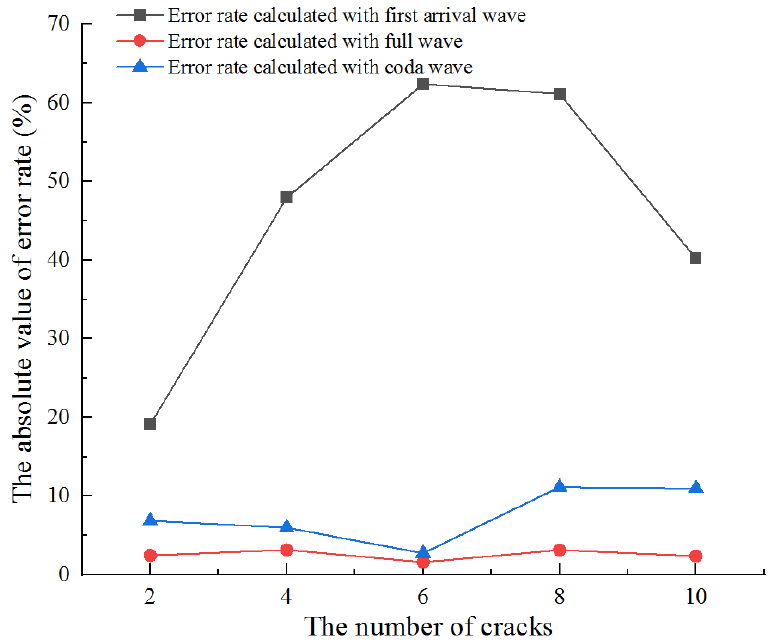
Figure 15. The error rate of wave velocity change rate calculated with different